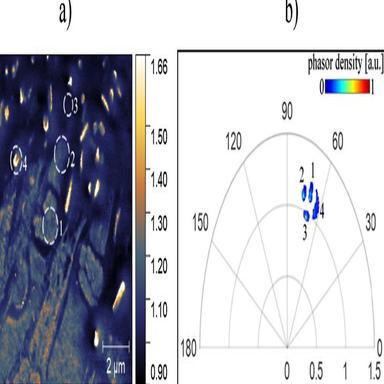
(a) The s-SNOM 3rd harmonic amplitude with marked positions of ROI 1 (inner segment of one photoreceptor – location of the mitochondria), ROI 2 (outer segment of the photoreceptor – the part that absorbs light), ROI 3 (part of the tissue surrounding the outer segment) and ROI 4 (RPE infiltration); b) phasor distribution density diagram for the four ROIs.